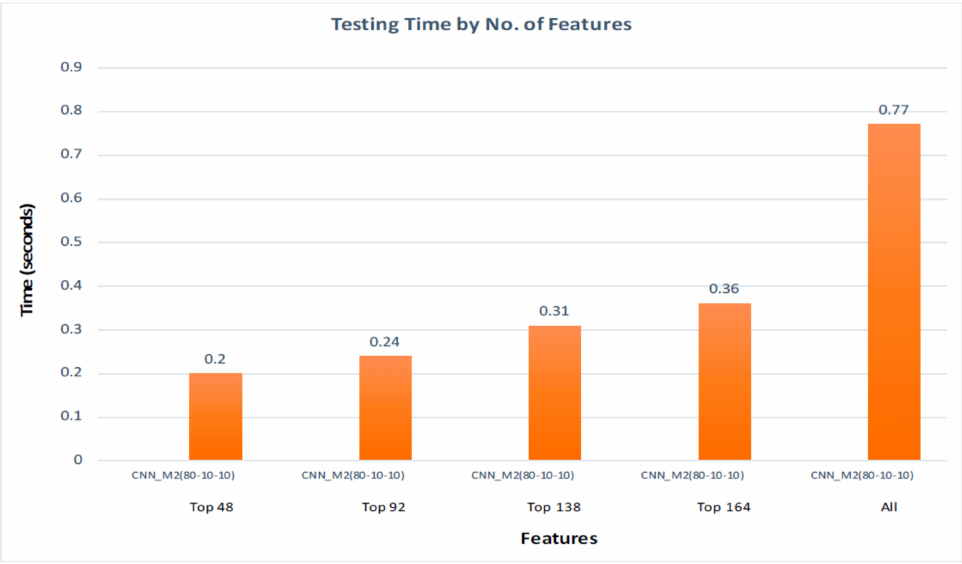
Figure 21. Testing time by number of features for